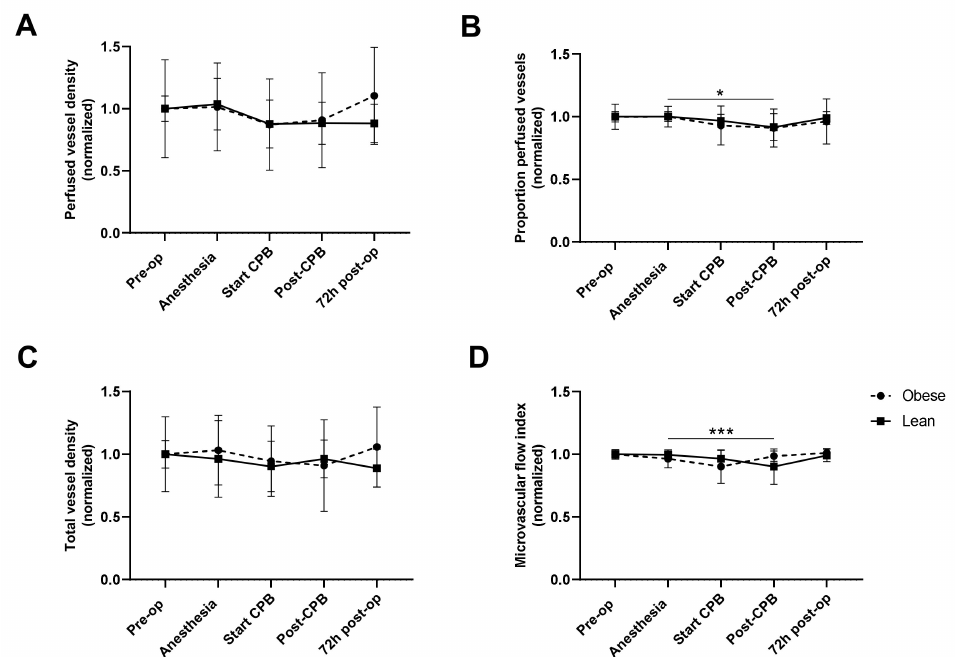
Figure 4. Sublingual microcirculatory perfusion as shown by perfused vessel density ( A ), proportion of perfused vessels ( B ), total vessel density ( C ), and microvascular flow index ( D ) measured before surgery (pre-op), after induction of anesthesia (anesthesia), 10 min after start of cardiopulmonary bypass (start CPB), 10 min after weaning from CPB (post-CPB), and 72 h after end of surgery (72 h post-op) in lean (black line) and obese (dotted line) patients. Data are normalized to pre-op, represented by mean ± SD, and tested with a two-way ANOVA and Bonferroni post hoc analysis; * p < 0.05, *** p < 0.001 time effect in lean